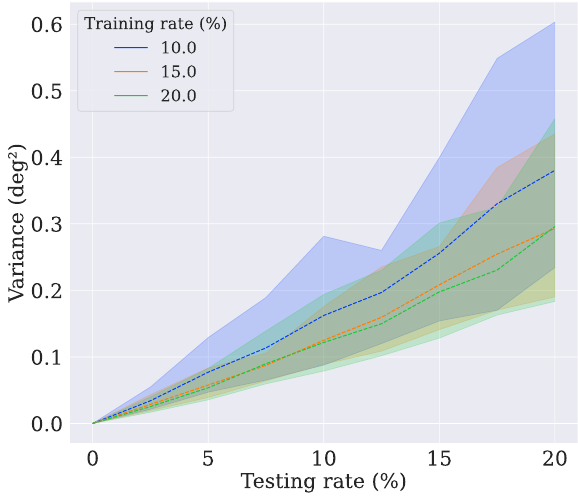
Figure 11. The evolution of the variance for test case